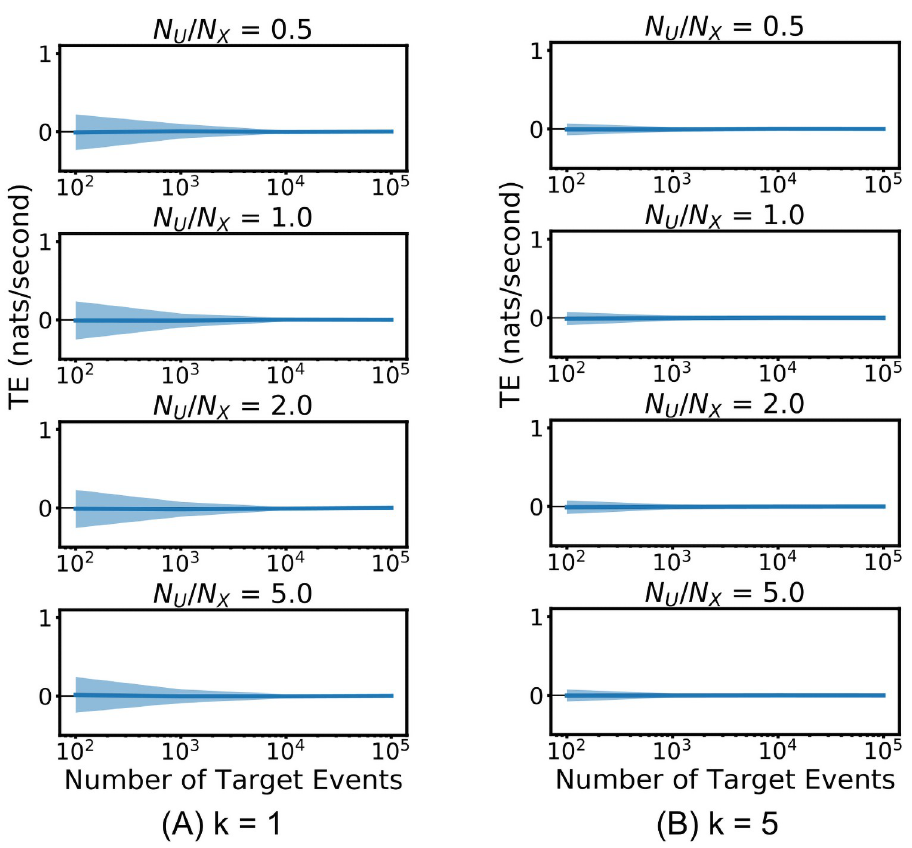
Fig 2. Evaluation of the continuous-time estimator on independent homogeneous Poisson processes. The solid line shows the average TE rate across multiple runs and the shaded area spans from one standard deviation below the mean to one standard deviation above it. Plots are shown for two different values of k nearest neighbours, and four different values of the ratio of the number of sample points to the number of events N U / N X (See